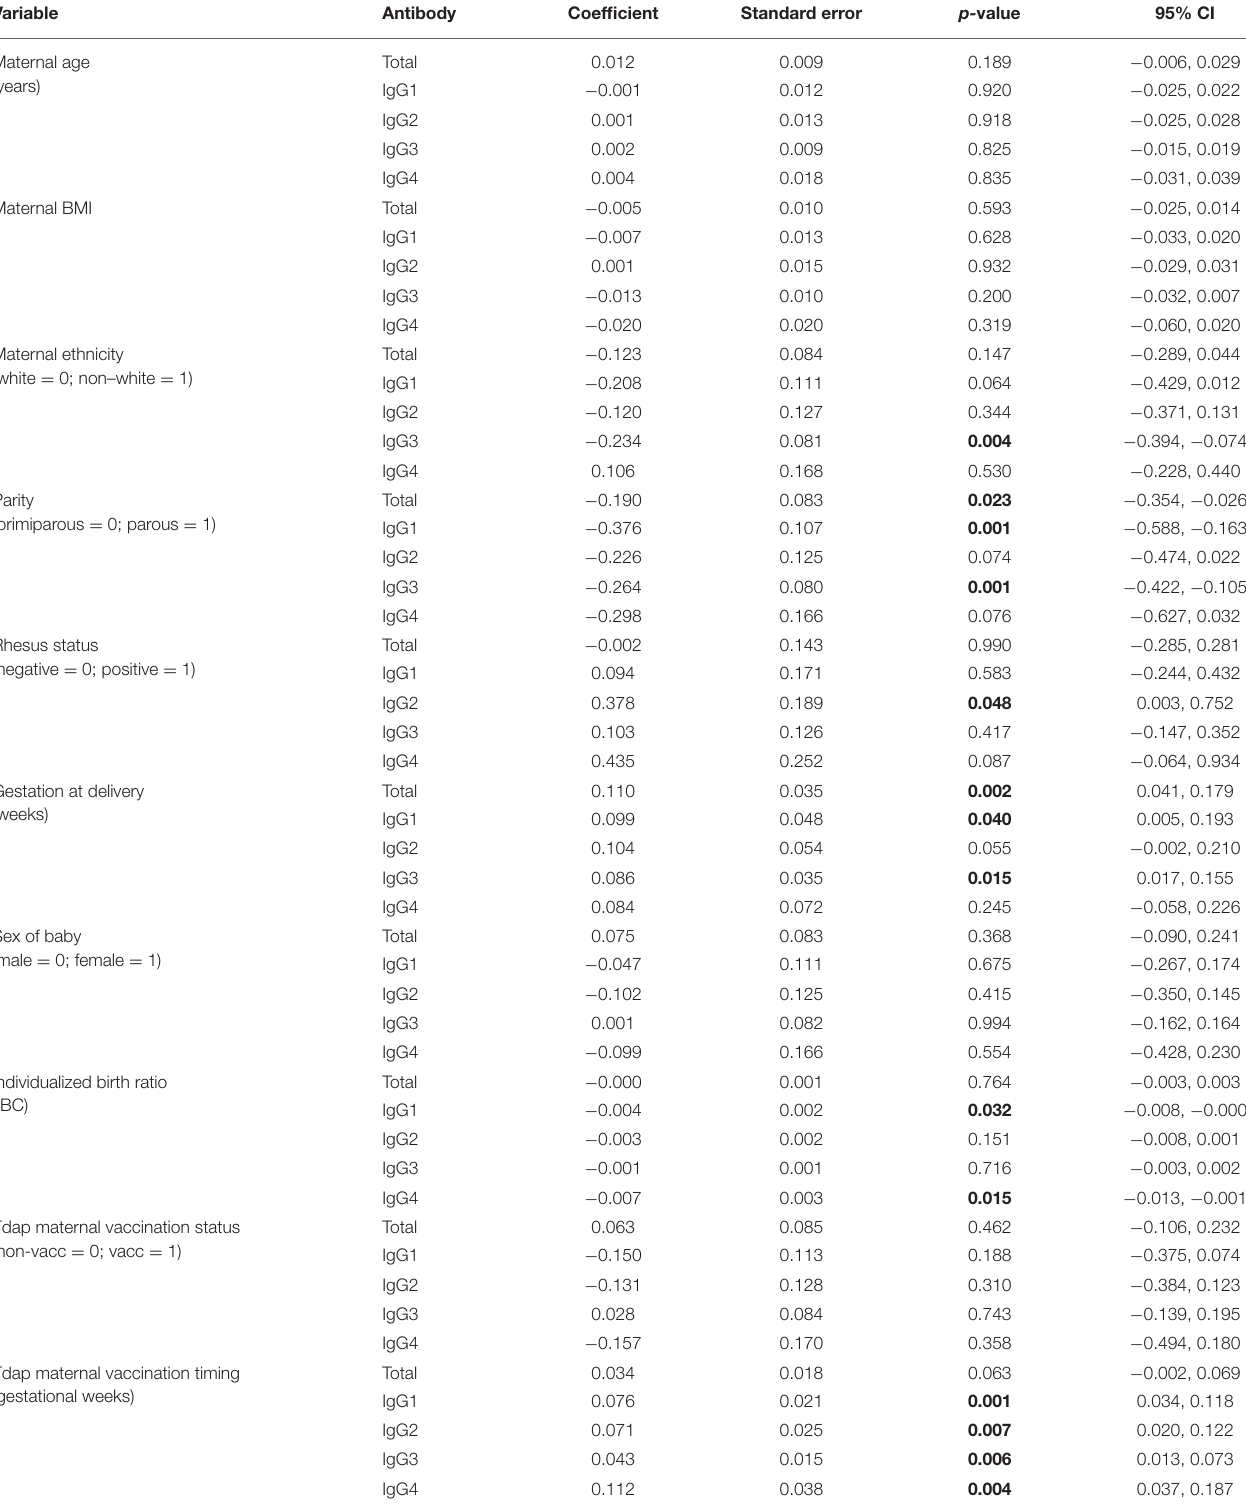
TABLE 4 | Unadjusted effects of clinical parameters on log(2) maternal to fetal IgG transfer ratios using simple linear regression based on n = 106 for total IgG and n = 116 for IgG subclasses.